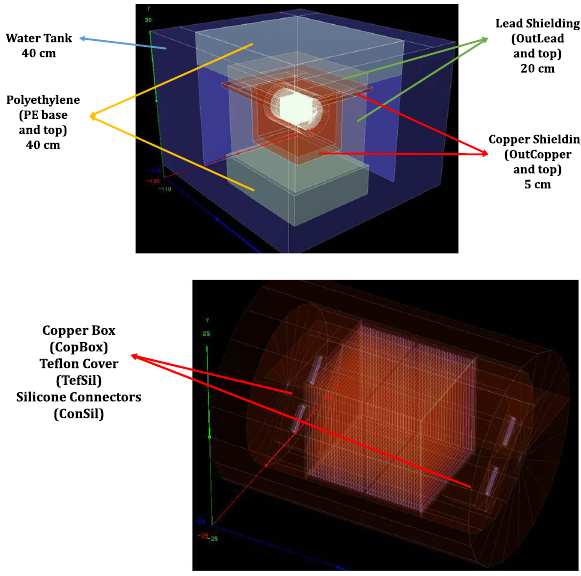
Fig. 5 Views of the geometry of TREX-DM implemented in the GEANT4 simulation code, showing the whole shielding (top) and the copper vessel